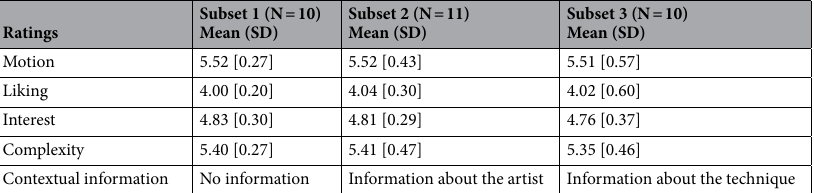
Table 1. Mean ratings of motion, liking, interest, and complexity across the three subsets of paintings. N = number of paintings, SD = standard